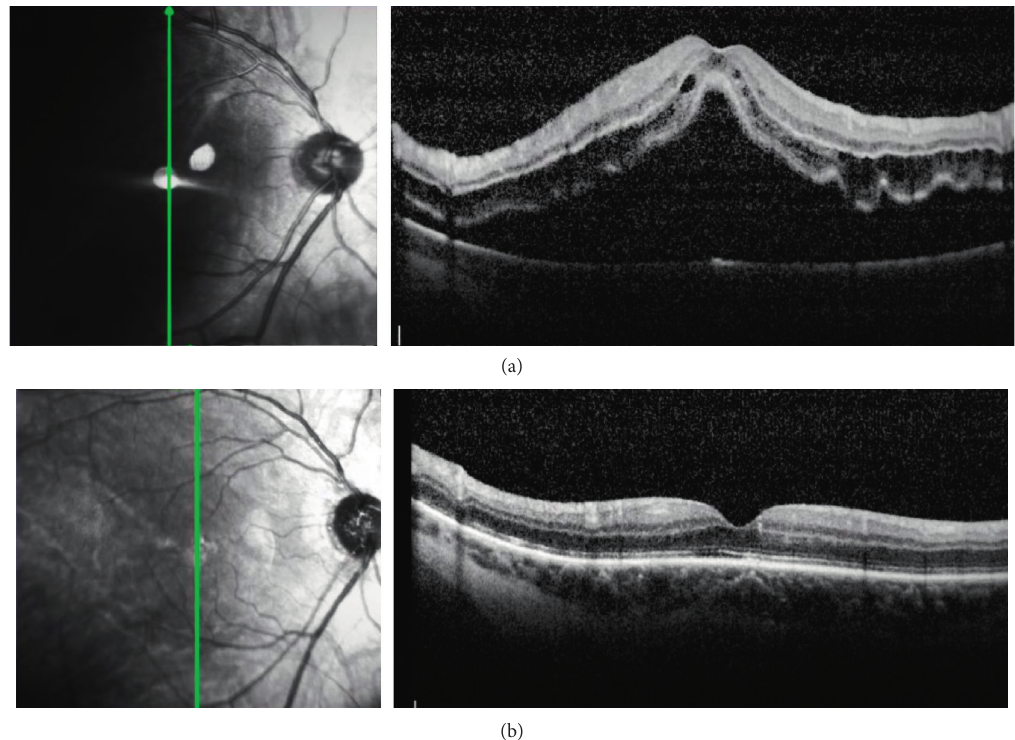
Figure 2: Preoperative SD-OCTimage (a) and six weeks’ postoperative SD-OCTimage (b) obtained after macula-off RRD surgery. Despite the fact that a residual fluid under the macula at the end of the surgical procedure was left, the anatomical macula reattachment appears satisfactory (b).